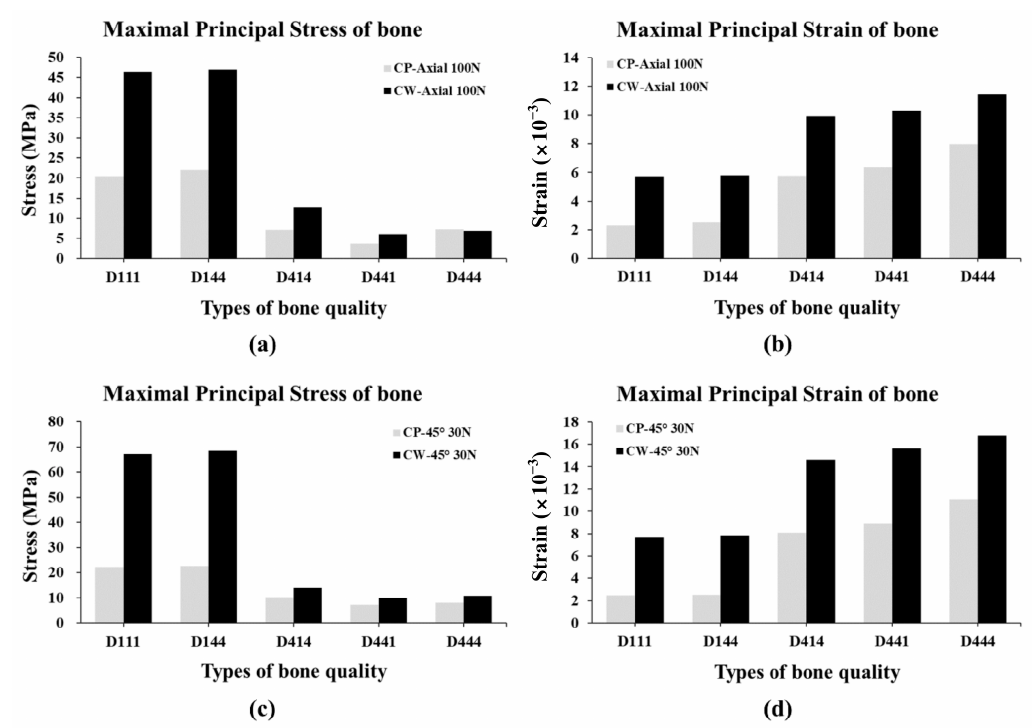
Figure 4. Maximal principal stress and maximal principal strain values in the 5 types of bone with 2 surgical methods. ( a ) Maximal principal stress, ( b ) strain values under 100 N axial load, ( c ) maximal principal stress, and ( d ) strain values under 30 N oblique (45 ◦ ) load. Table 4. The maximal principal stress and strain of CP and CW in five bone-quality